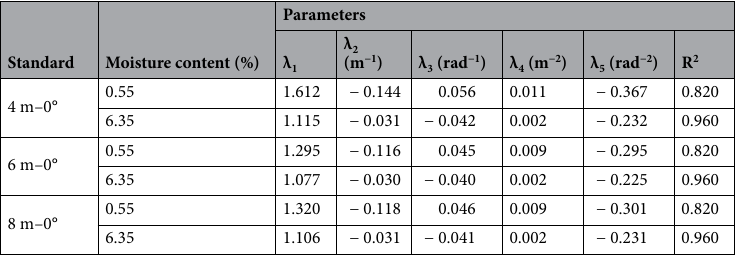
Table 4. Fitting parameters and their evaluation of the established correction models based on different standards.